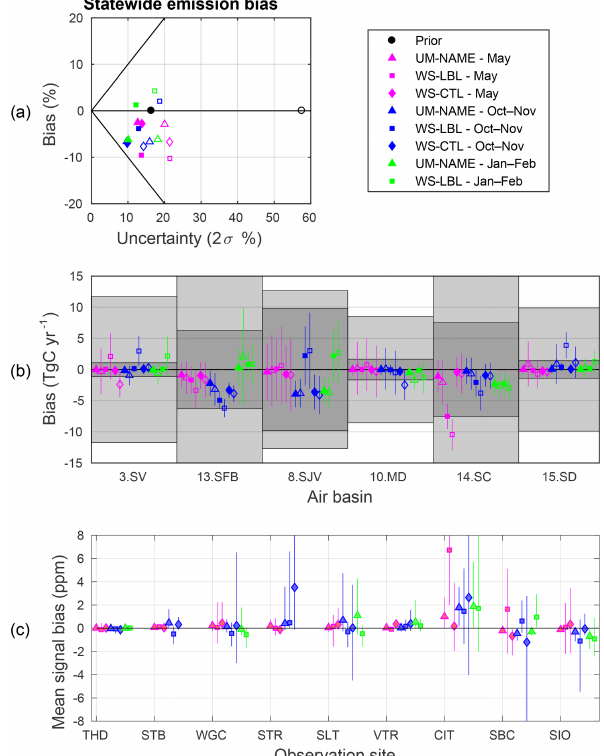
Figure 4. (a) Statewide and (b) individual air basin inversion re- sults for an error in the spatial distribution of prior emissions. Prior emissions are given by EDGAR scaled to Vulcan emission totals in each air basin, and true emissions are given by Vulcan; (c) shows the mean signal error in simulated average ffCO 2